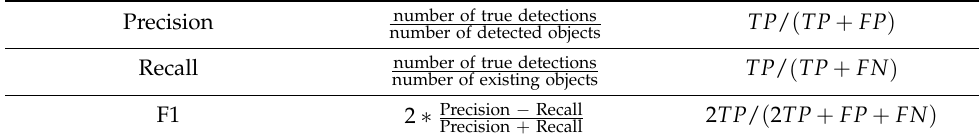
Table 1. Evaluation metrics. Precision number of true detections Recall number of true detections